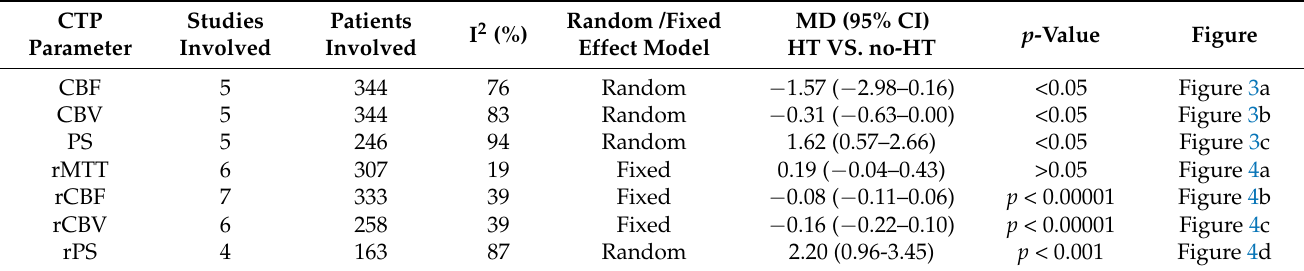
Table 5. Meta ‐ analysis of CTP parameter values between HT and non ‐ HT groups . Table 5. Meta-analysis of CTP parameter values between HT and non-HT